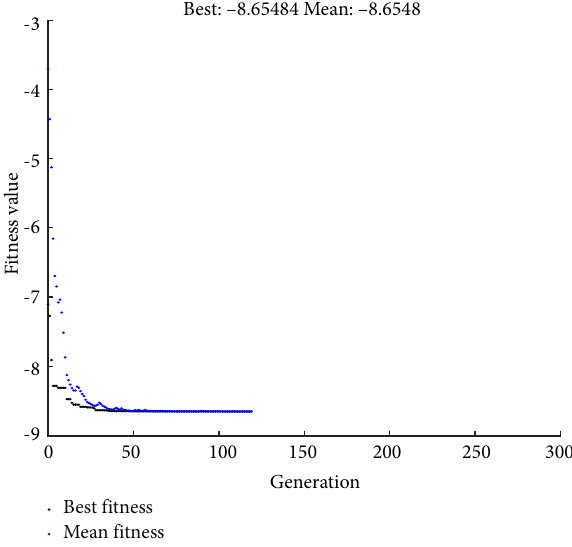
Figure 3: Generation and best-mean fitness